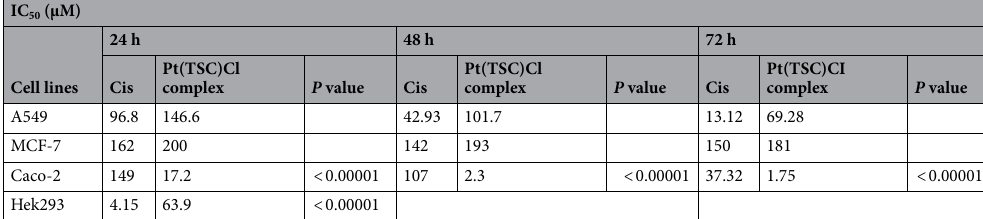
Table 5. The IC 50 value of Pt(TSC)Cl complex and cisplatin on cancer and normal cell lines. *Cis: Cisplatin, A549: Human lung cancer cells, Caco-2: Human colon cancer cells, MCF-7 Human breast cancer cells and Hek293: Human embryonic kidney